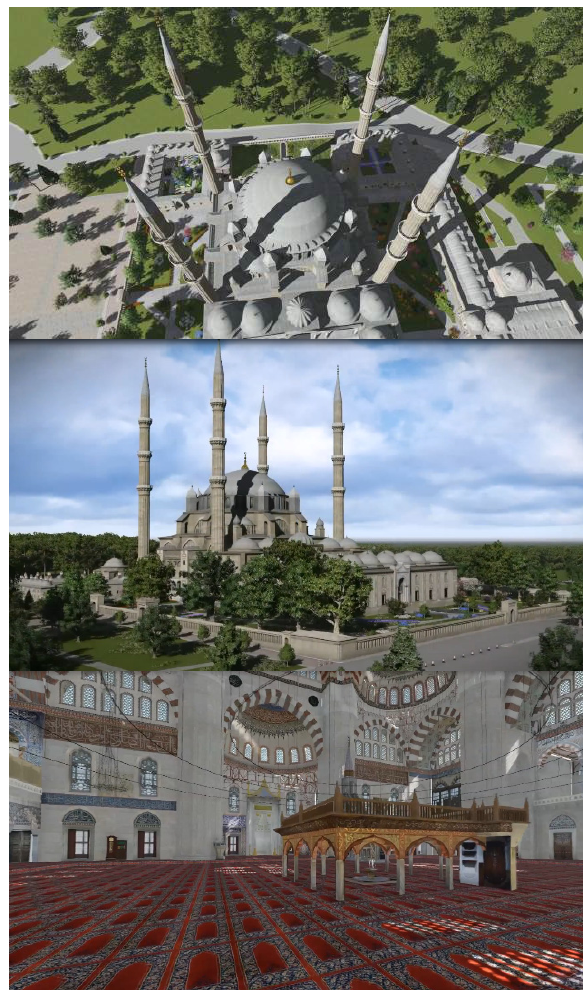
Figure 6. Still video frames of the video sequence of the Selimiye mosque of Edirne – perspective views of the exterior (top and centre) and interior (bottom)